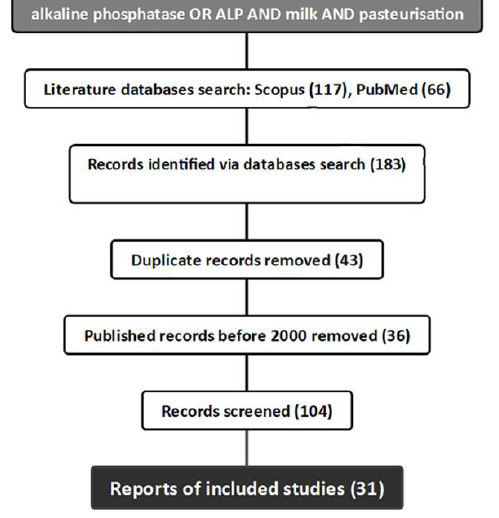
Figure 1. Systematic literature review and study selection strategy.